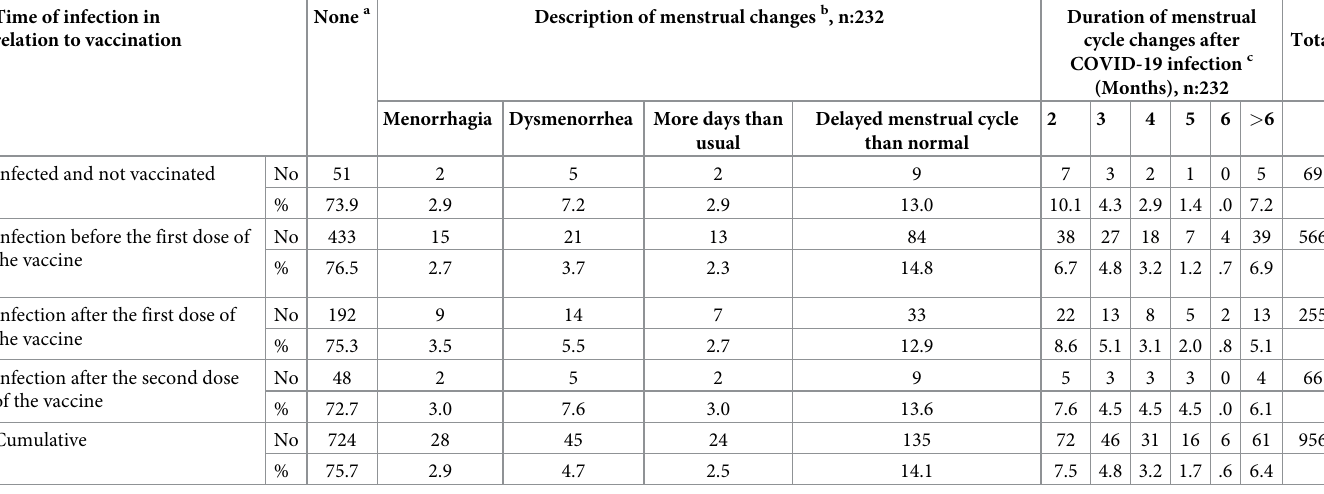
Significant variation (P < 0.008) was reported among participants who suffered from differ- ent COVID-19 disease severities (Table 4). A significant reverse correlation was detected between COVID-19 disease severity and the type of menstrual cycle changes (P < 0.001, R = -0.134). Similarly, a statistically significant correlation (P < 0.001, R = -0.144) has been found between disease severity and the duration of menstrual cycle changes. The milder the disease Table 3. Effect of time of infection on the time of vaccination on the development of menstrual cycle changes following SARS-CoV-2 infection. Time of infection in None a Description of menstrual changes b , n:232 Duration of menstrual relation to vaccination cycle changes after COVID-19 infection c